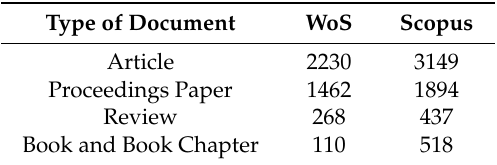
Table 1. Distribution of publications by type of